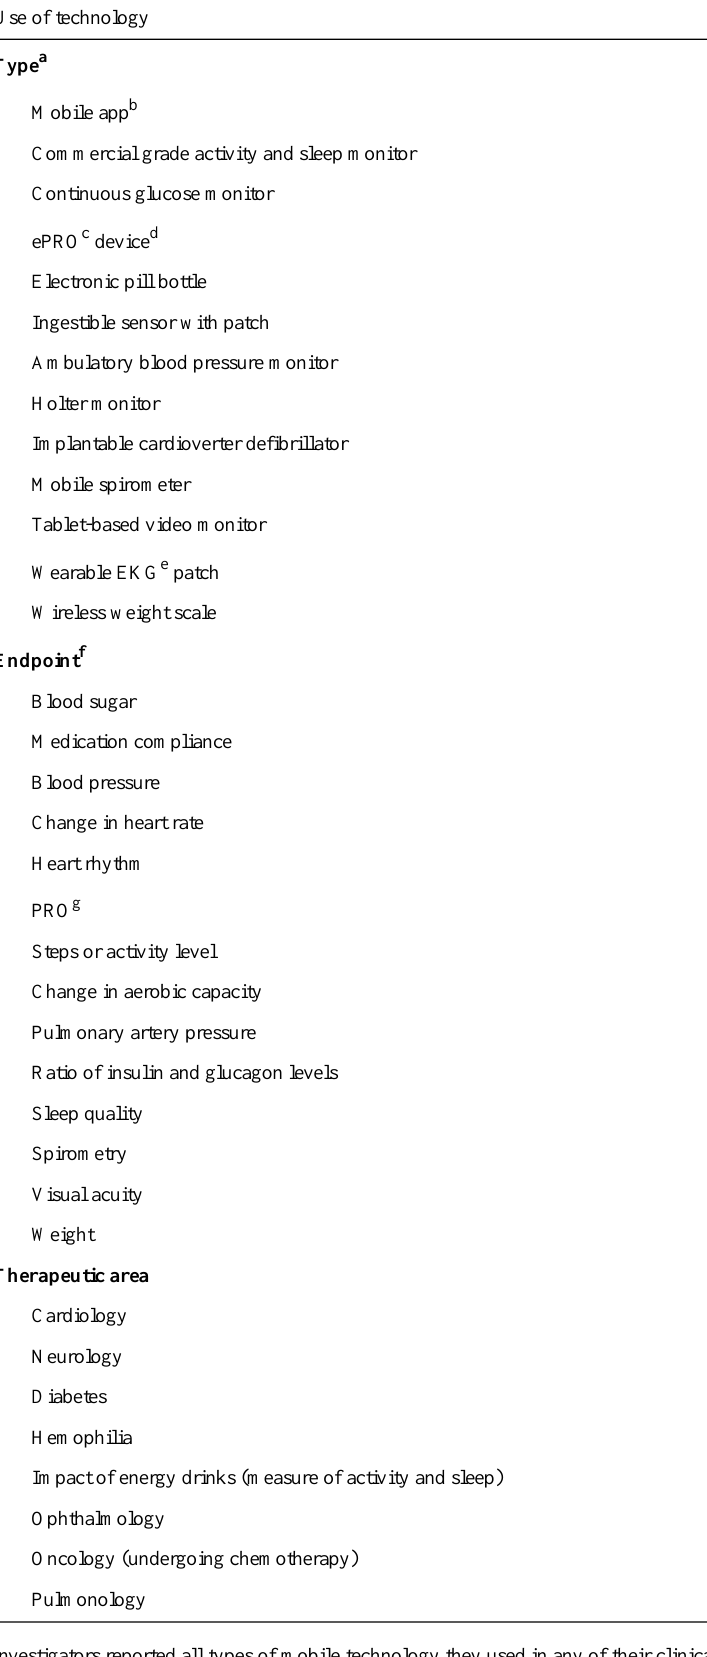
Table 2. Investigators’use of technology: type, endpoint, and therapeutic area of investigation (N=12).